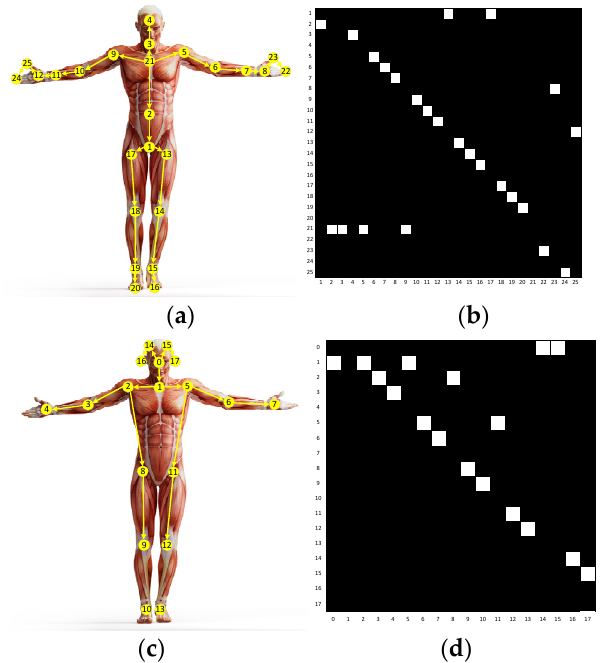
Figure 3. Images ( a , c ) represent the human skeletons in the NTU-RGB-D 60 and Kinetics-Skeleton datasets respectively. Images ( b , d ) represent the adjacency matrices corresponding to Images ( a , c ) .